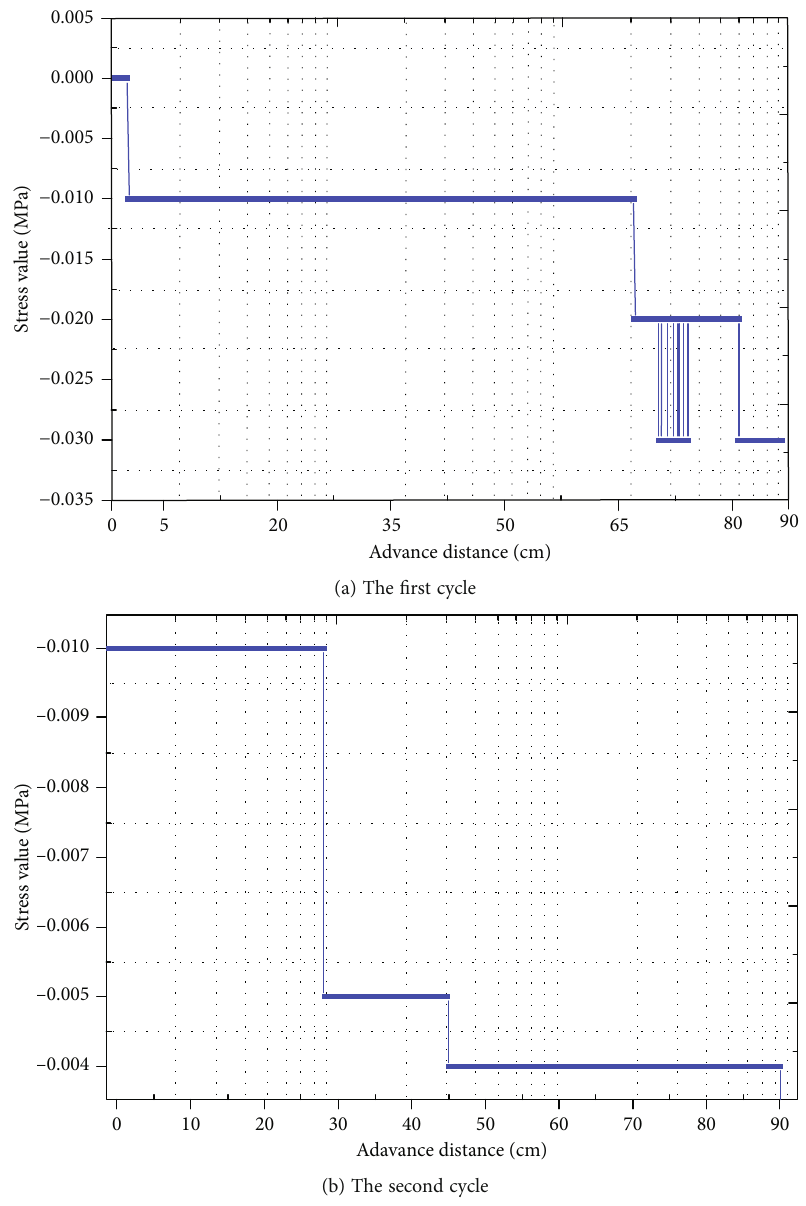
Figure 17: Stress at monitoring point S2-5 vs. the distance